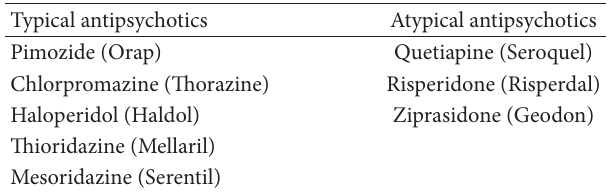
Table 5: Antipsychotropic medications with potential risk for QTc interval prolongation.